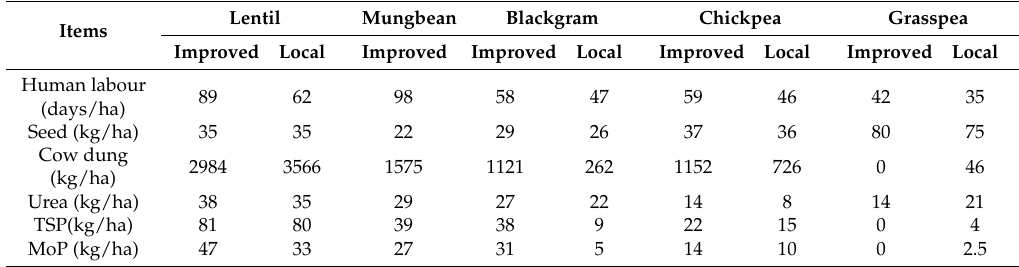
Table 3. Input use pattern of local and HYV pulses production in the study